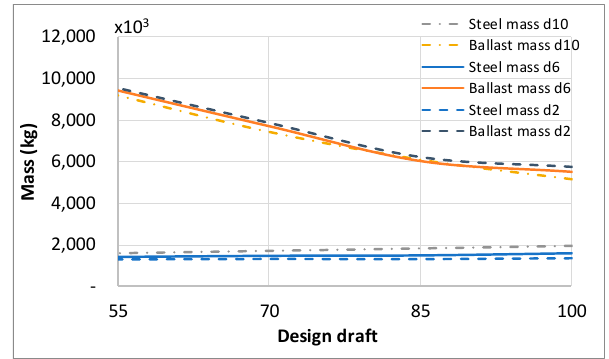
Figure 7. Relation between mean pitch angle at rated thrust force for the spar-type platform with a moonpool wind turbine with differences in displacement, draft and moonpool diameter of the platform.